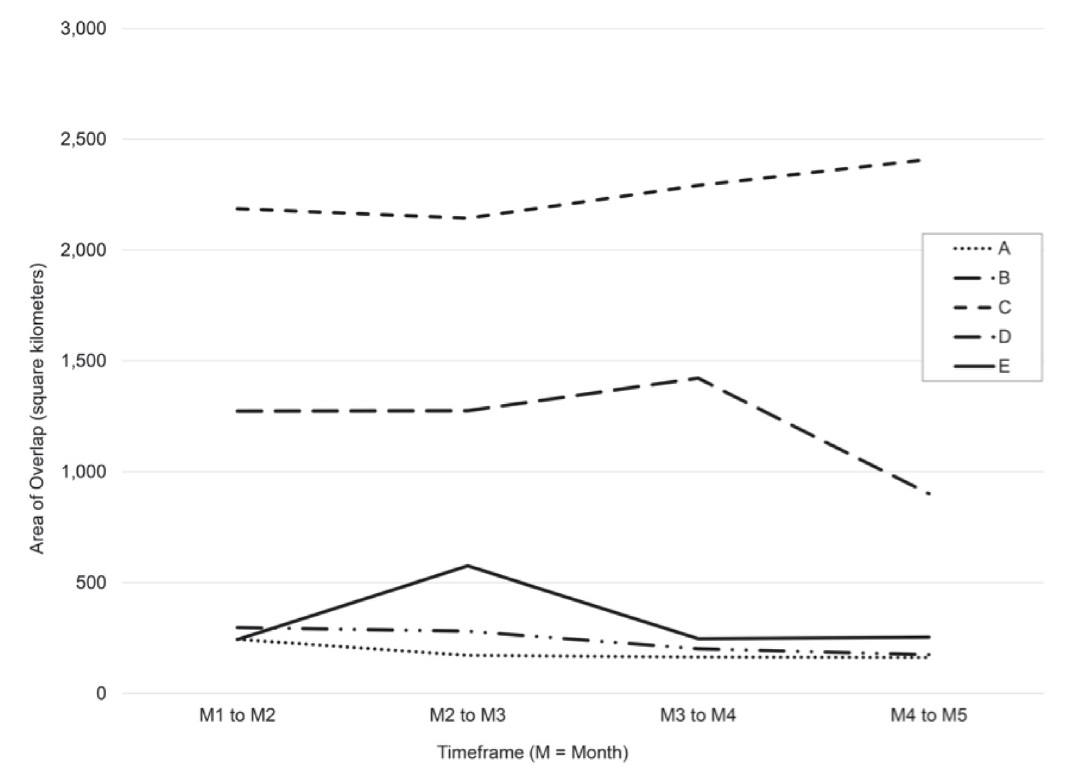
Figure 6. Area of overlap between Driving Areas from month to month.